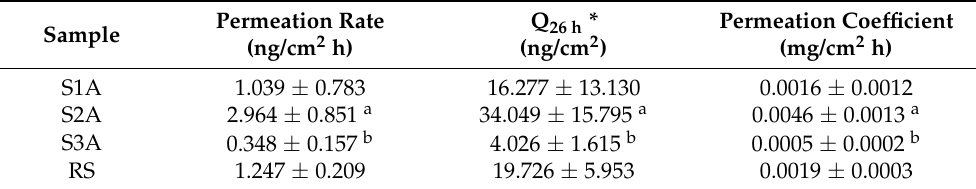
Figure 5. In vitro permeation profiles of BDP determined across the heat-separated porcine ear epidermis (mean ± SD, n = 5) reflecting the influence of differences in formulation composition of the investigated samples on in vitro BDP skin absorption. Table 4. Permeation parameters of BDP from tested film-forming formulations (S1A, S2A and S3A) and reference betamethasone ointment 0.5 mg/g (RS) obtained using porcine ear epidermis as the membrane (mean ± SD, n = 5).